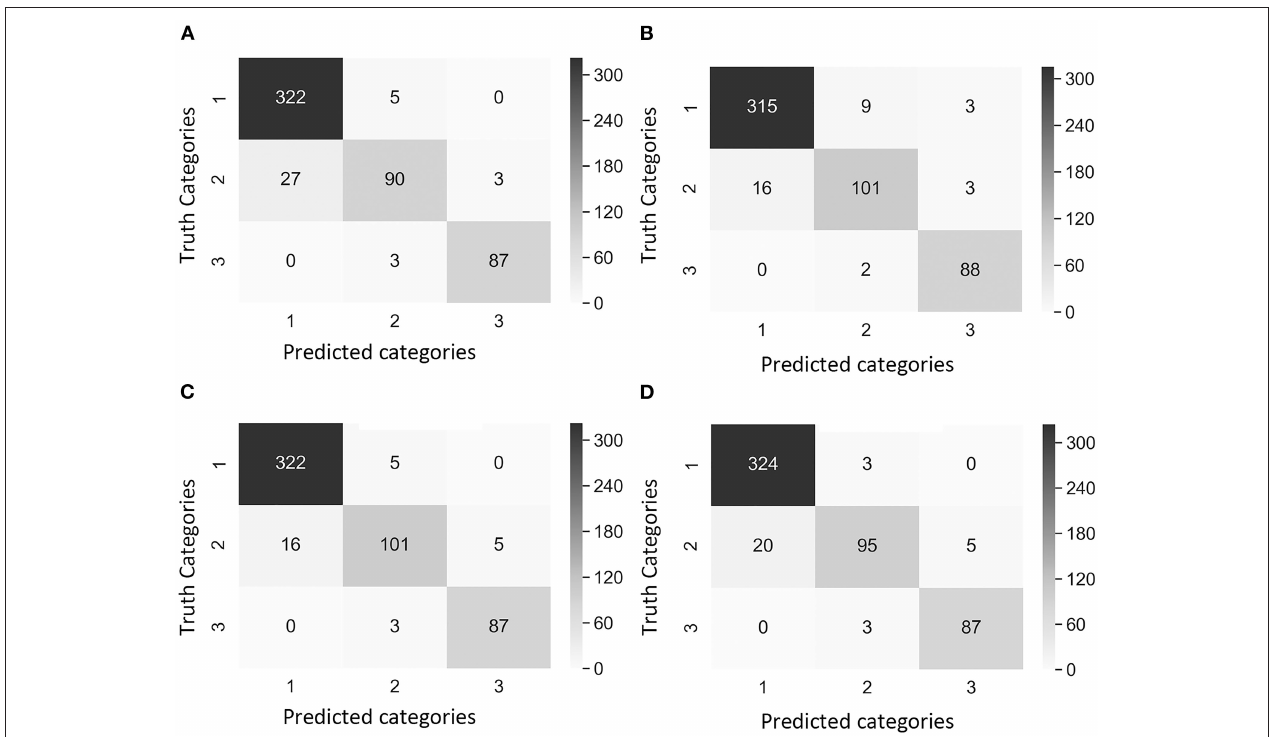
FIGURE 5 | Confusion matrix of the images of Dataset 2 (non-matured spikes only) showing “true” categories by Rater 1 (y-axis) and the predicted categories by the CNN model (x-axis). Category 1: contained images with 0% severity, Category 2: 0.1–20% severity, Category 3: 20.1–100% severity. The cases of study presented different weights in the loss function [weight in Category 1, weight in Category 2, and weight in Category 3]. (A) Case 1 [1, 1, 1], (B) Case 2 [1, 10, 1], (C) Case 3 [2, 5, 1], and (D) Case 4 [2, 1, 1]. Values and color intensity represent number of